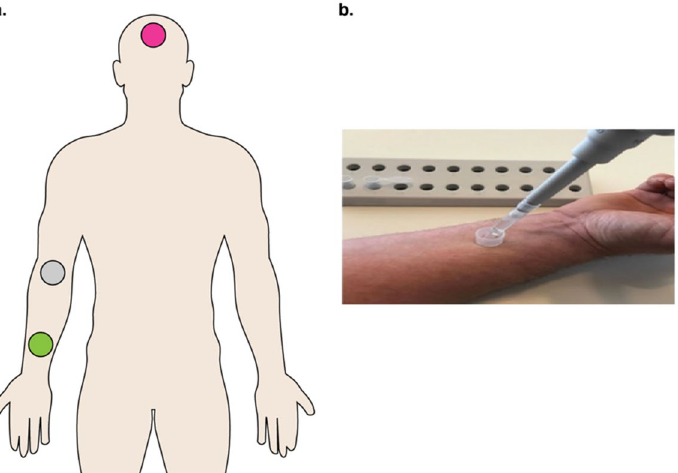
Figure 1. Overview of sampling procedure used in this study. ( a ) Standardized sampling locations for healthy- weight controls and patients with AN included the forehead, a sebaceous zone (pink), the antecubital fossa/ inner elbow, a moist zone (grey), and the ventral side of the lower arm, a dry zone (green). Patients were positioned accordingly to facilitate sampling procedures, e.g., supine for forehead sampling. Illustration by B. Hermes. ( b ) Sampling procedure of the distal (lower) forearm. Image photographed by Bendix et al. 28